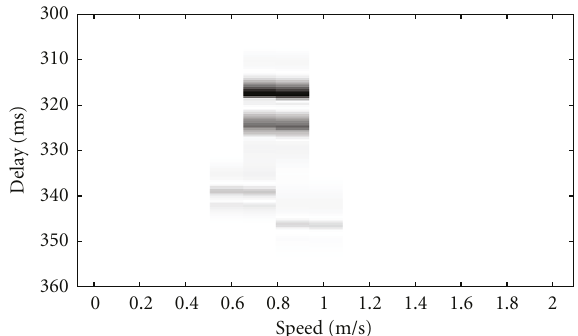
Figure 15: Wideband ambiguity function of the received LFM signal in the BASE07 experimental data. The crosses represent the positions of the four detected path groups.